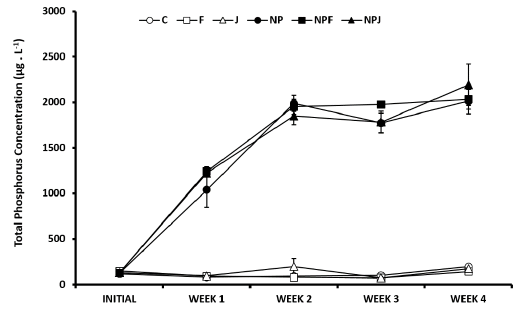
Figure 1. Medium values(+ - SE) for Total Phosphorus concentration analysis in six combinations of nutrients (NP), fingerlings (F) and juvenile (J) Nile tilapia treat- ments in a four-week tropical shallow lake experiment.